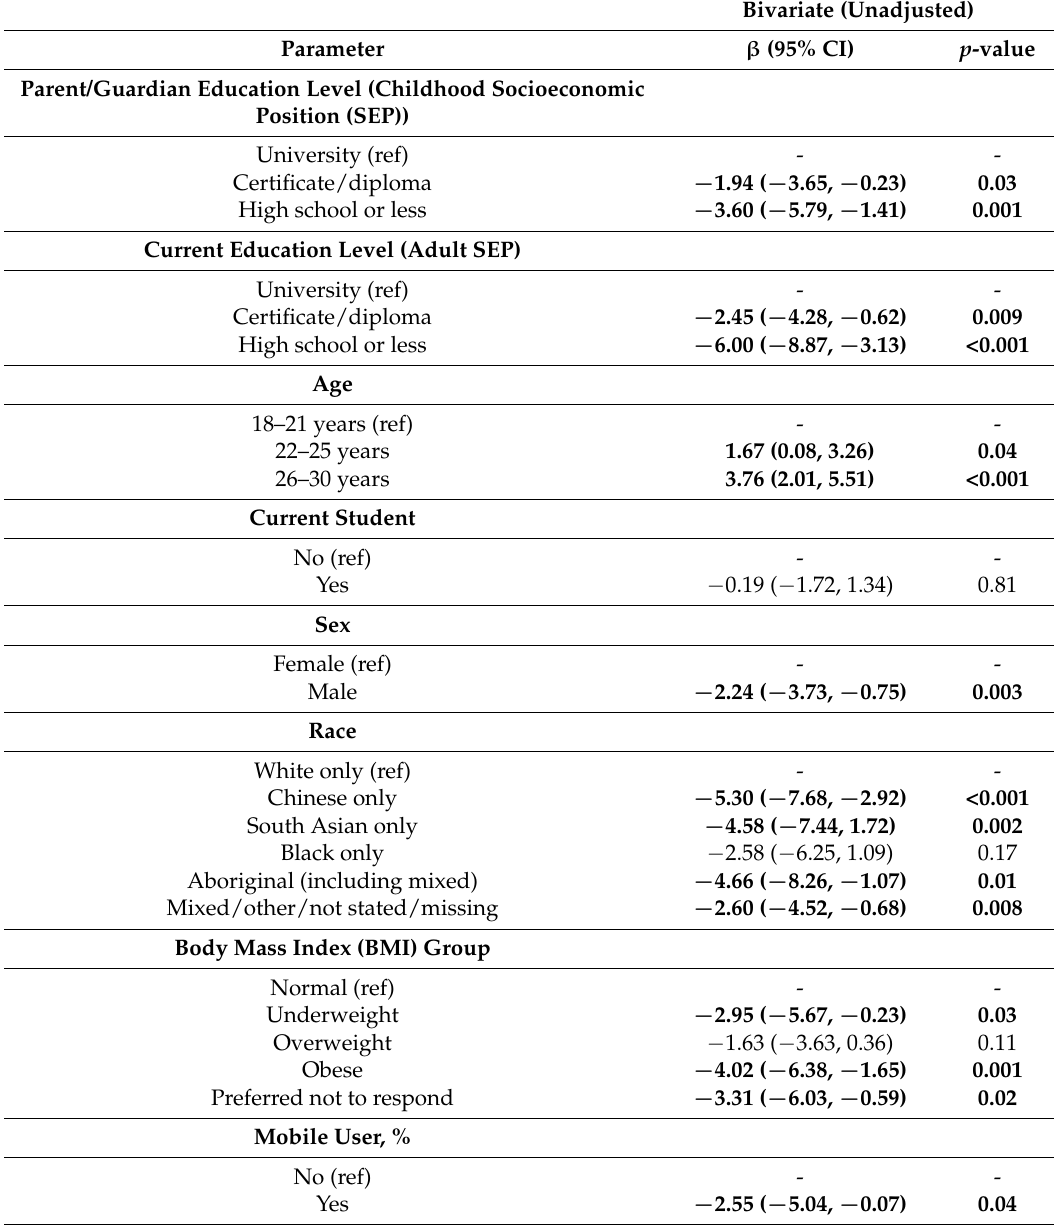
Table 2. Bivariate (unadjusted) associations between all variables and Healthy Eating Index-2015 (HEI-2015) scores in young